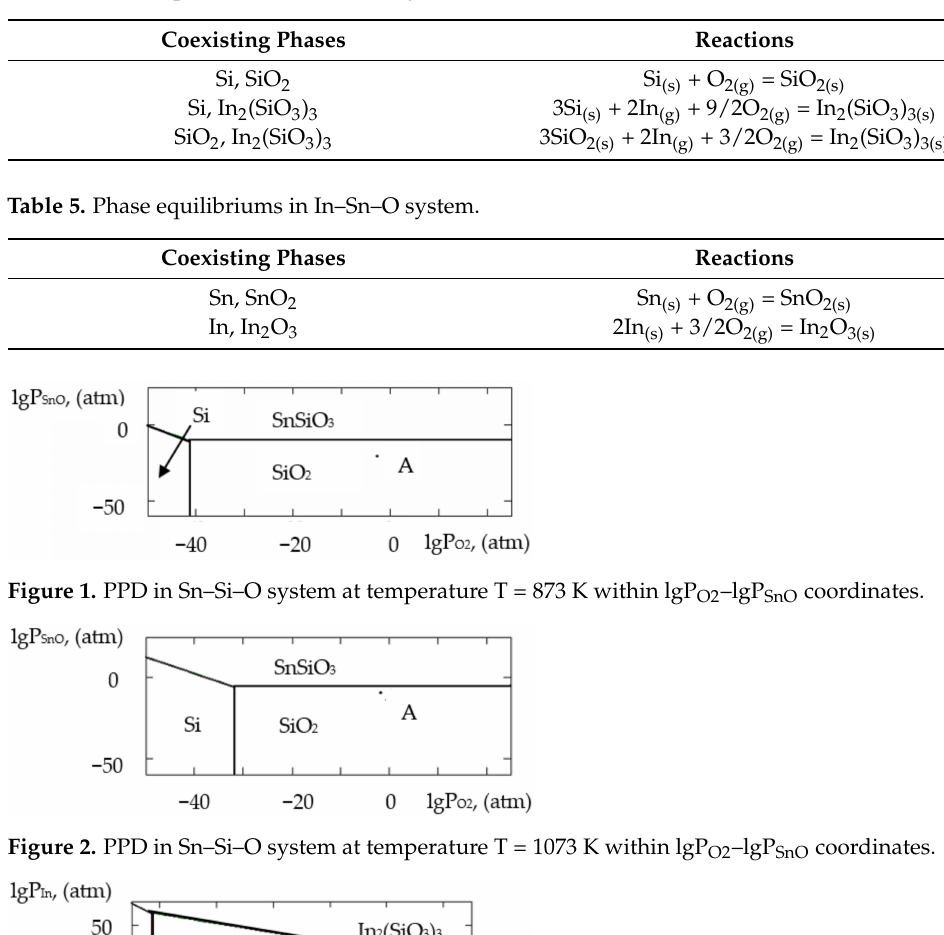
Table 4. Phase equilibriums in In–Si–O system.